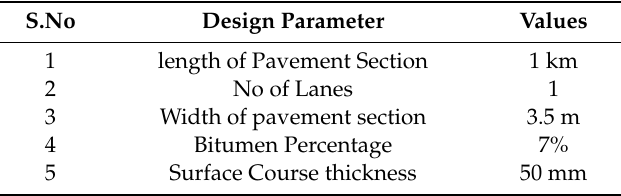
Table 5. Description of road section and bitumen saving.